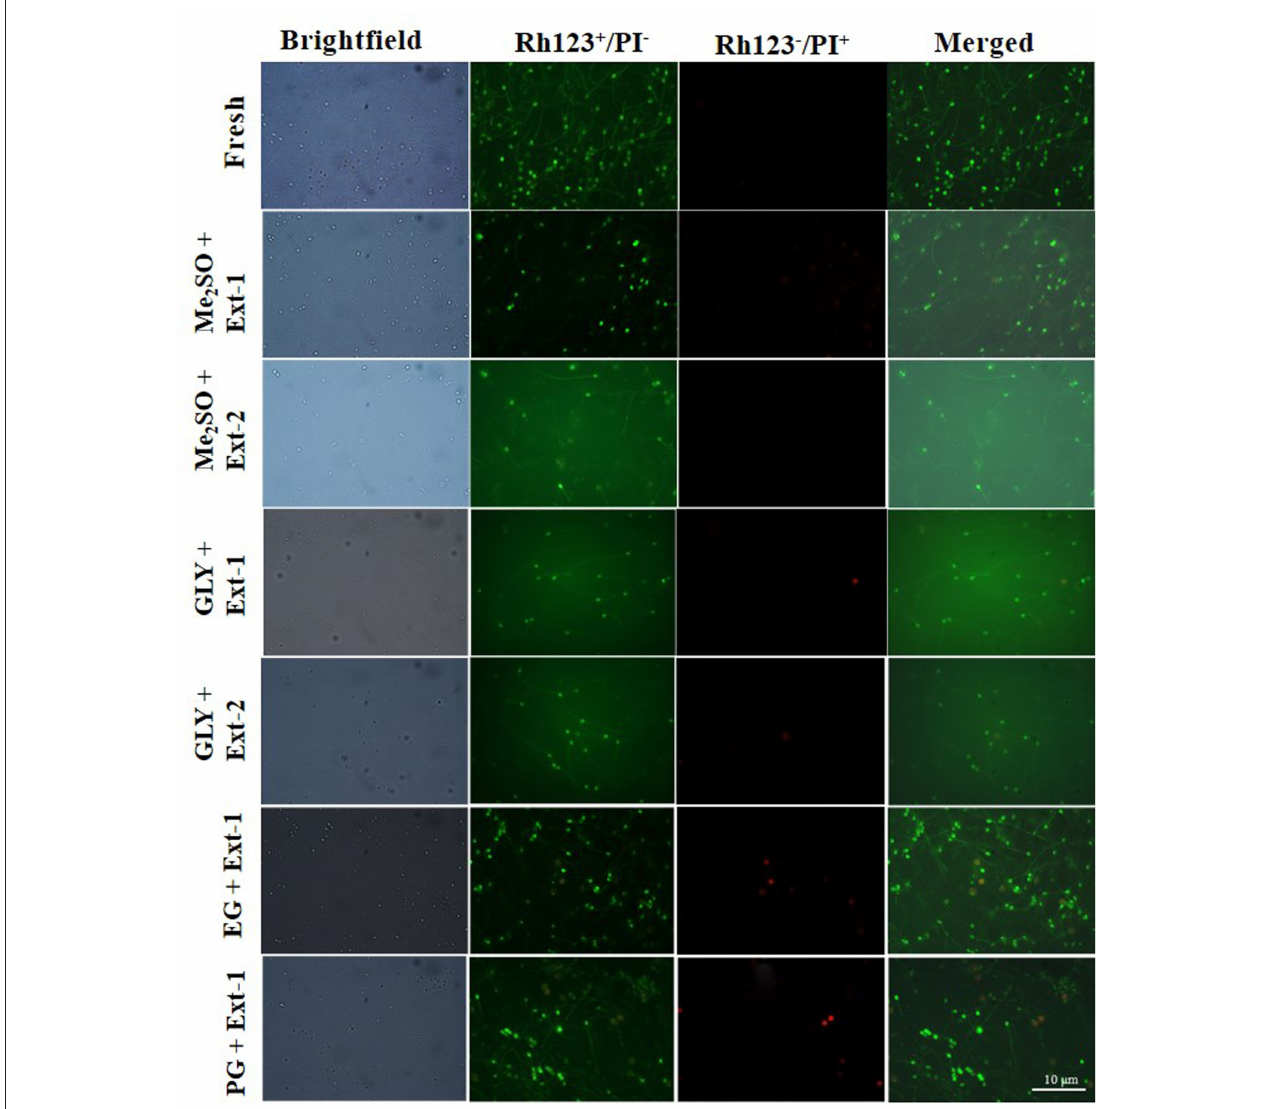
FIGURE 7 | Fluorescent-stained photographs for detecting mitochondrial membrane potential of cryopreserved marbled flounder sperm ( × 100